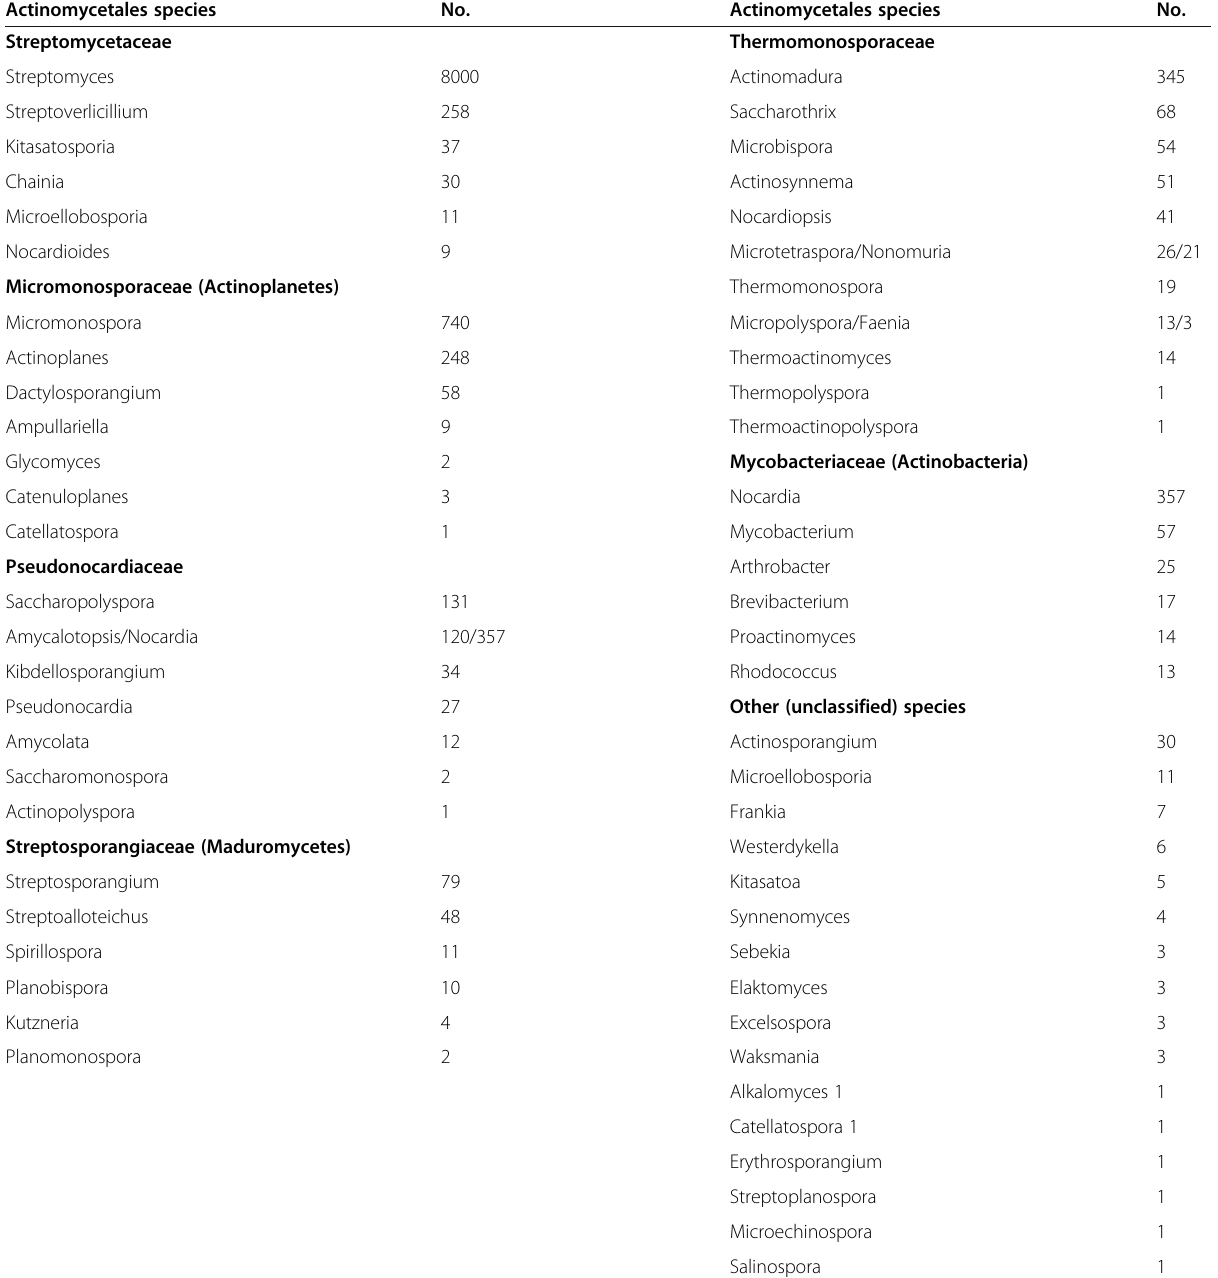
Table 2 Numbers of actinomycetales species, including the all rare actinos, known to produce bioactive metabolites, are summarized